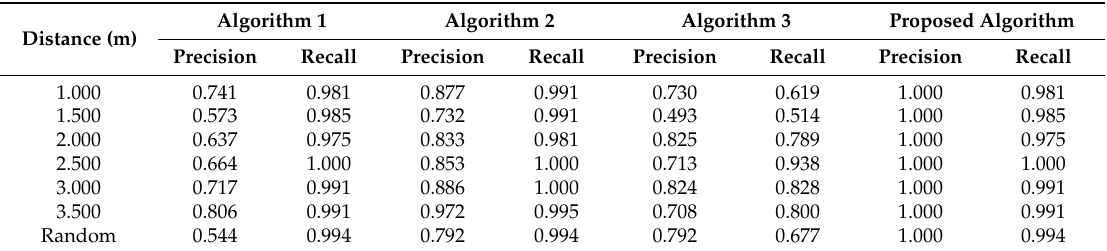
Table 1. Average precision and recall values for the proposed and benchmark algorithms at different distances.